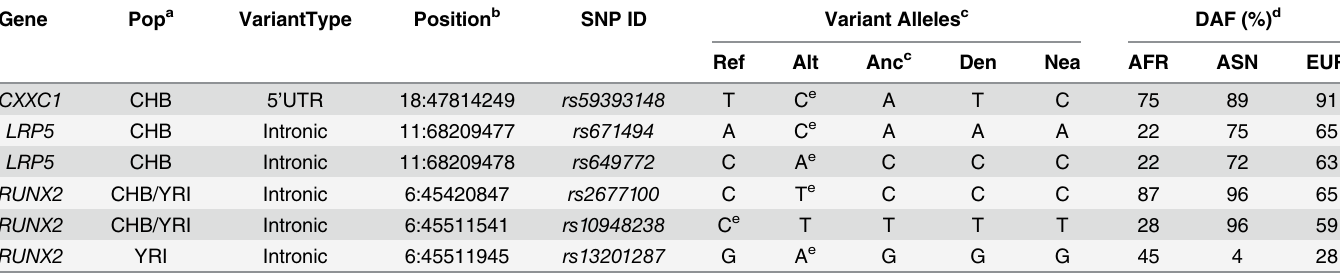
Table 1. Candidate regulatory